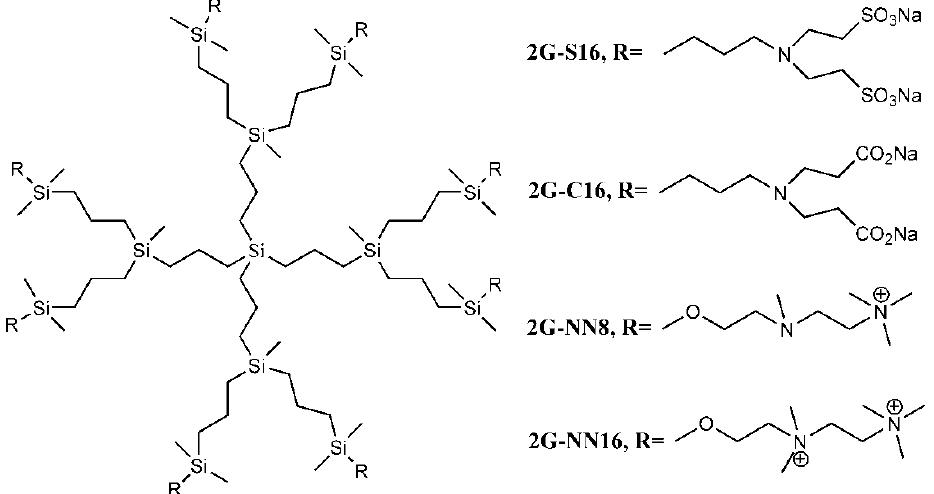
Figure 2. Generation 2 carbosilane dendrimers with different end